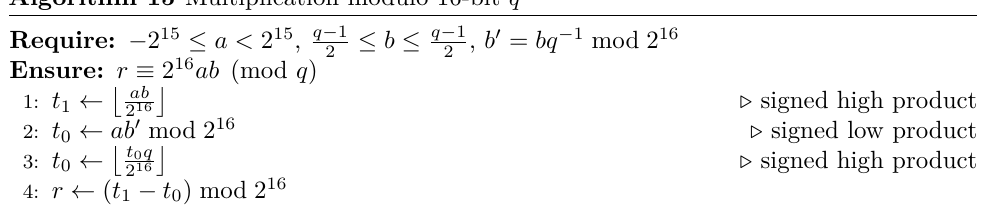
Algorithm 15 Multiplication modulo 16-bit